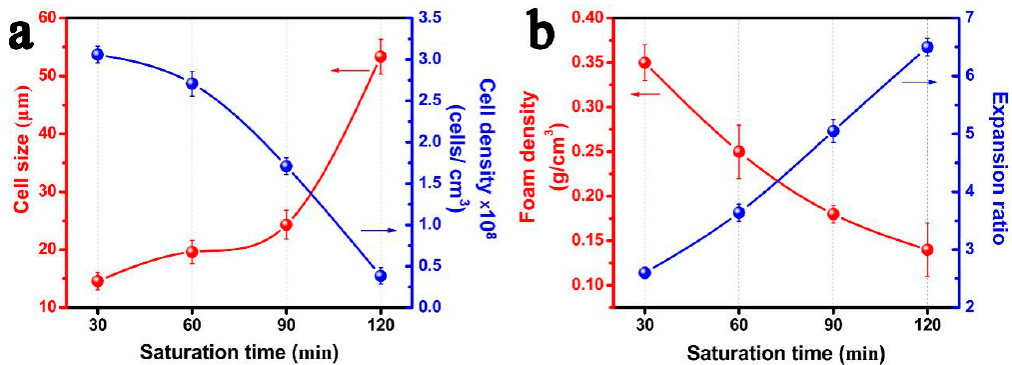
Figure 9. ( a ) Average cell diameter and cell density, ( b ) Foam density and expansion ratio of PP/FKM(1.0) foams prepared at different saturation times (30 min, 60 min, 90 min, and 120 min).